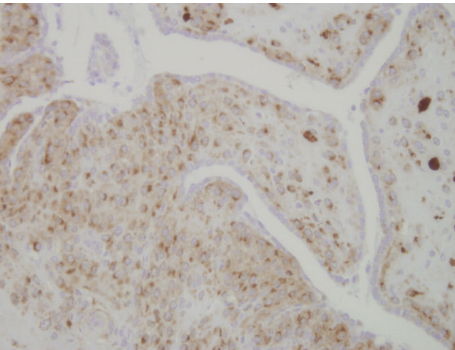
Figure 5: Immunohistochemical micrograph of the tumor. The majority of tumor cells were positive for renin, although the tubular lining was